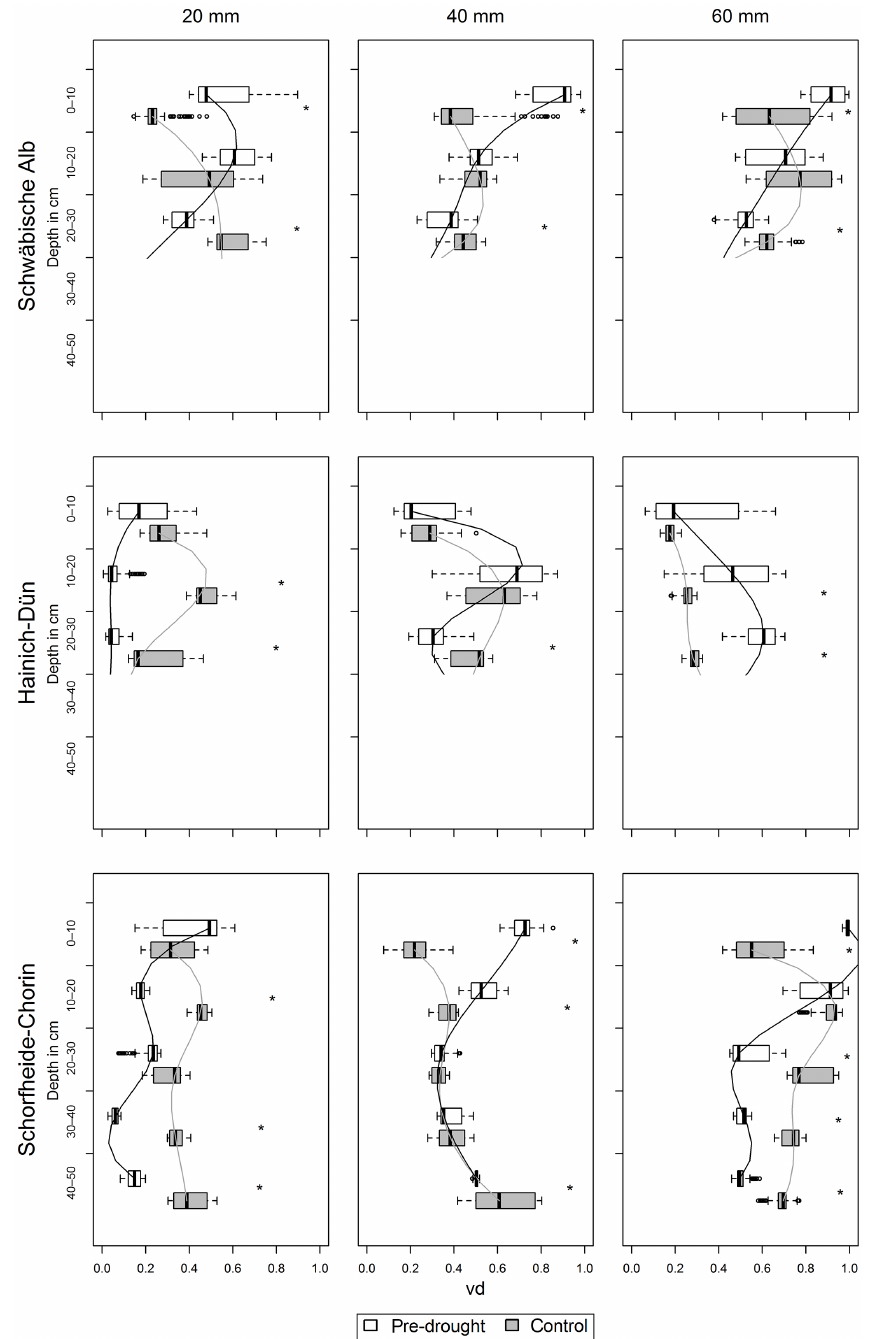
Figure 7. VD box plots of the drought and the pre-drought pattern. Depth ranges are omitted, where one of the profile is shorter than the other. Statistically significant ( p value ≤ 0.01) differences between the treatments are marked with an asterisk.